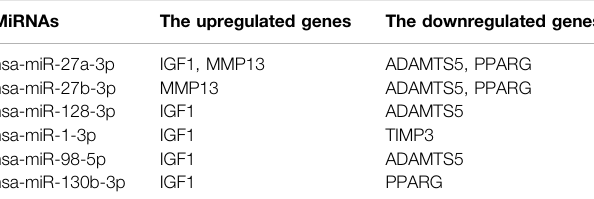
TABLE 4 | Six hub miRNAs from the CyTargetLinker that coregulate fi ve hub genes involved in osteogenic and adipogenic differentiation. MiRNAs The upregulated genes The downregulated